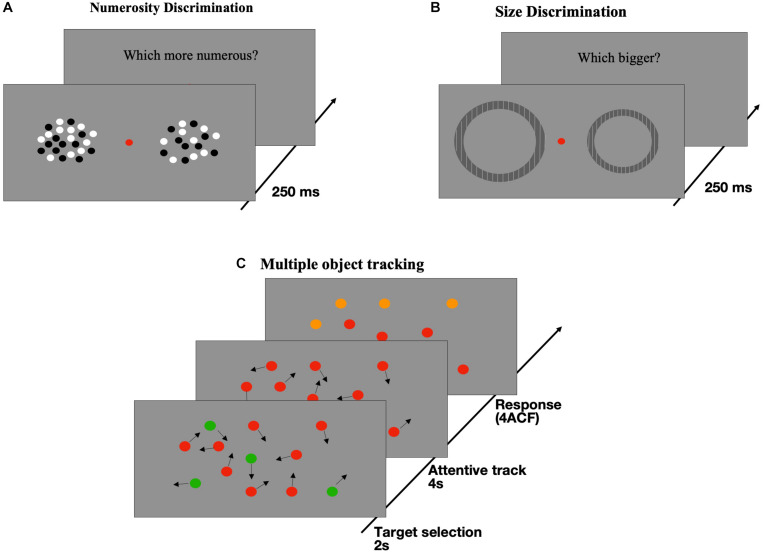
Illustration of tasks and stimuli. (A)
Numerosity Discrimination: two patches of dots were briefly (250 ms) presented to both side of a central fixation point. Subjects were required to select which dots ensemble was more numerous. (B)
Size Discrimination: Participants were asked to indicate which of two briefly (250 ms) presented annuli was perceived as being larger (method adapted from Pooresmaeili et al., 2013). (C)
Multiple Object Tracking (MOT): At the beginning of the session, some disks (2, 3, or 4) out of twelve were colored in green with the remaining being red. All dots moved randomly on the screen (7°/s) for a period of 2 s then the green disks turned red (like the distracters) and subjects had to track them for 4 s. At the end of the tracking period, all dots stopped and 4 of them turned orange with one of the orange dots being green at the beginning. This dot was the target subjects had to indicate in a 4-alternative forced paradigm (4ACF).